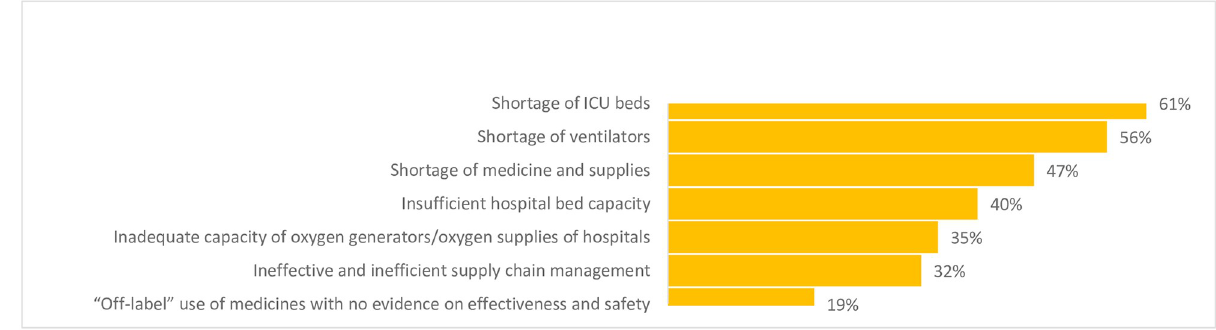
PLOS ONE | https://doi.org/10.1371/journal.pone.0268386 June 3,